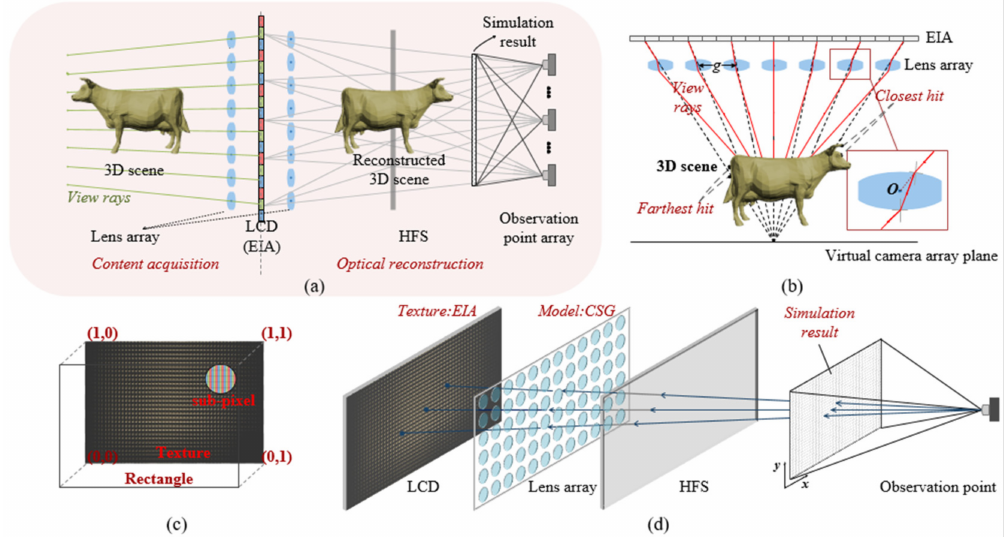
Figure 4. Schematic diagrams of the simulation system: ( a ) the simulation process of content acquisition and optical reconstruction; ( b ) the EIA generation process based on BRT; ( c ) the texture of the LCD plane model; and ( d ) the reconstructed result computation process based on